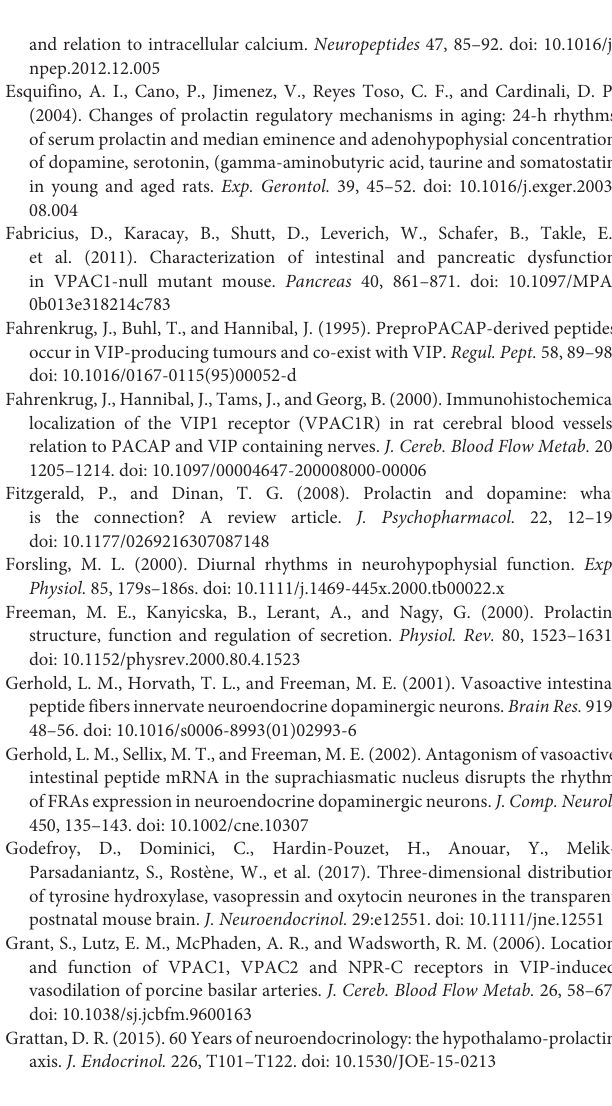
SUPPLEMENTARY FIGURE 1 | Distribution of VPAC1 immunoreactivity in the mid part of PVN in a VPAC1 knockout mouse. The VPAC1 mice were originally characterized by Fabricius et al. (2011). These mice had exon 4–6 deletion making a functional knockout, but a truncated part of the N-terminal receptor protein was still expressed resulting in a positive staining using our VPAC1 antibody (see also “Materials and Methods” section). Scale bars: = 100 µ